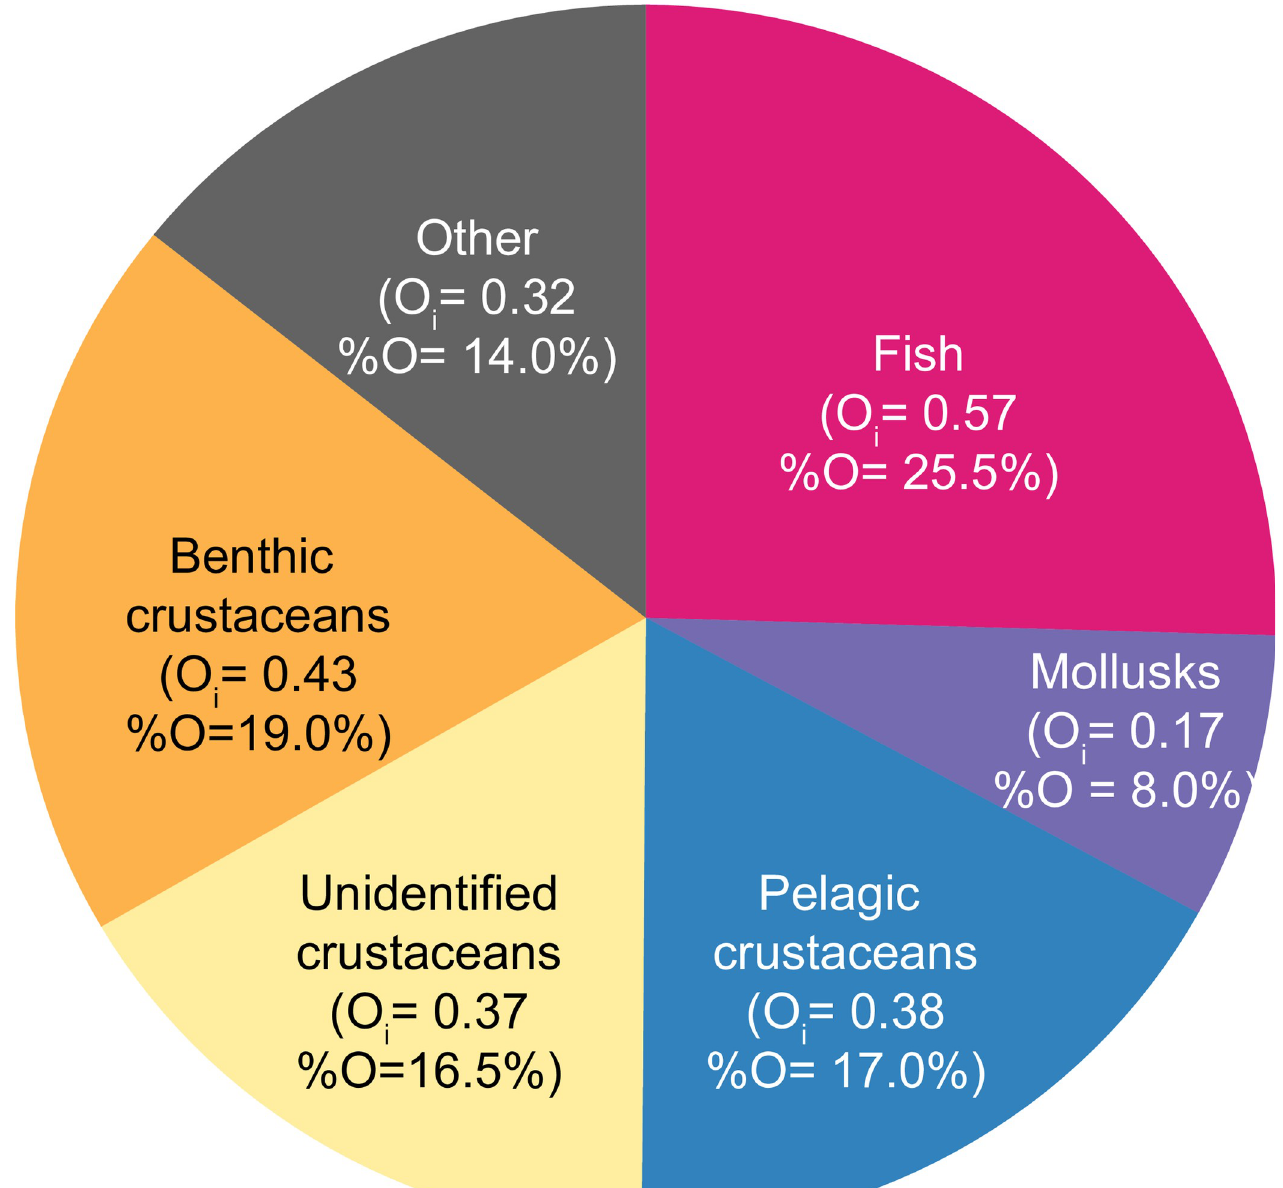
Fig 2. Whiting diet averaged over seasons and size classes, expressed as frequency of occurrence (O i ). Since a stomach may contain several preys, the sum of the frequencies of occurrence represents more than 1. For each prey group, frequencies of occurrence were scaled to 100% for the graphical representation